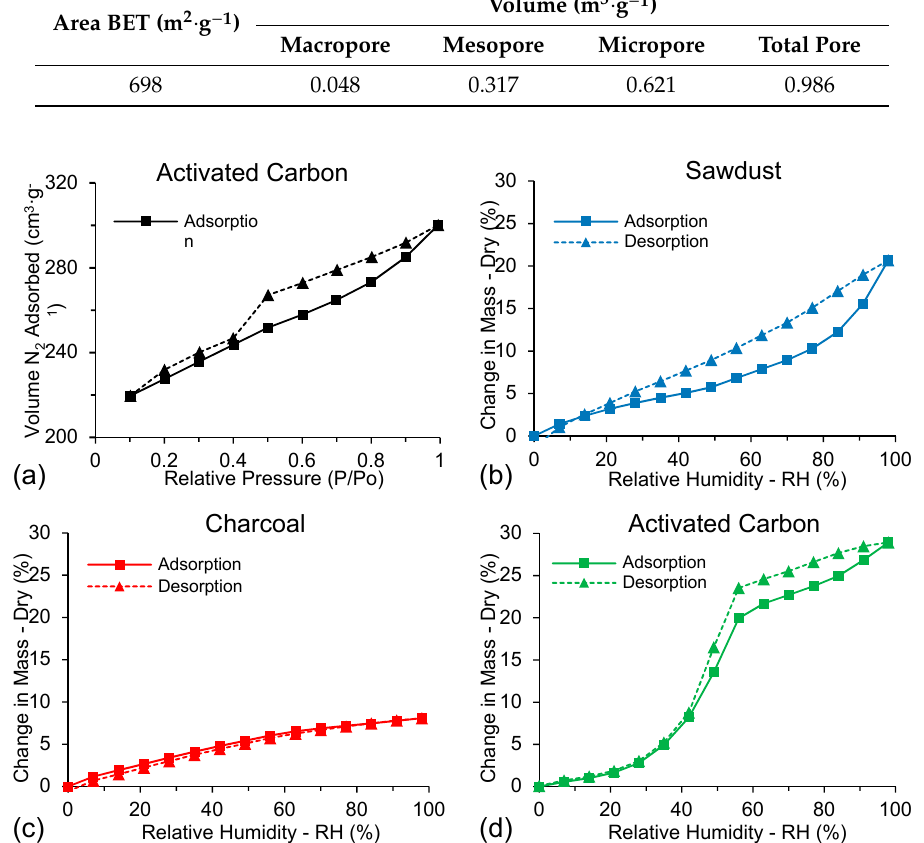
Figure 5. Isotherms of materials derived from massaranduba showing adsorption/desorption of nitrogen (gas) at − 196 °C for activated carbon (AC) ( a ); and water sorption/desorption isotherms for sawdust ( b ), charcoal ( c ) and activated carbon (AC) ( d ).